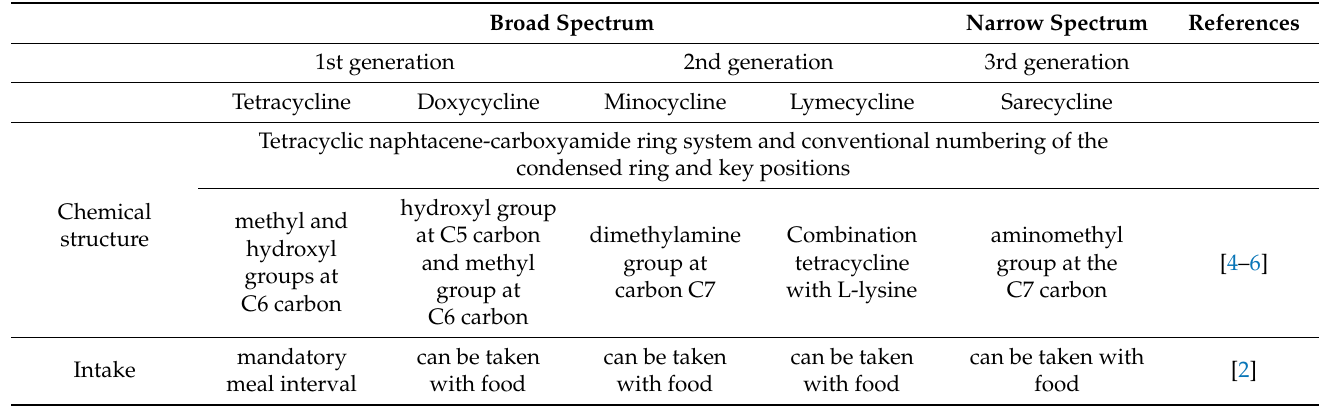
Table 1. Characteristics of tetracycline